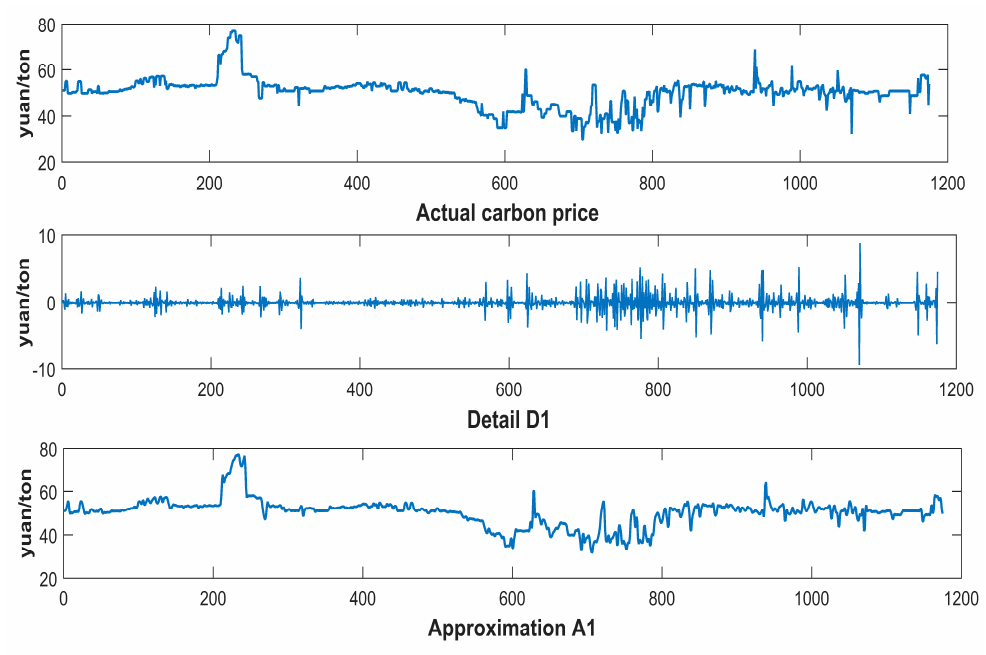
Figure 6. The wavelet transform (WT) results on the Beijing carbon price series.